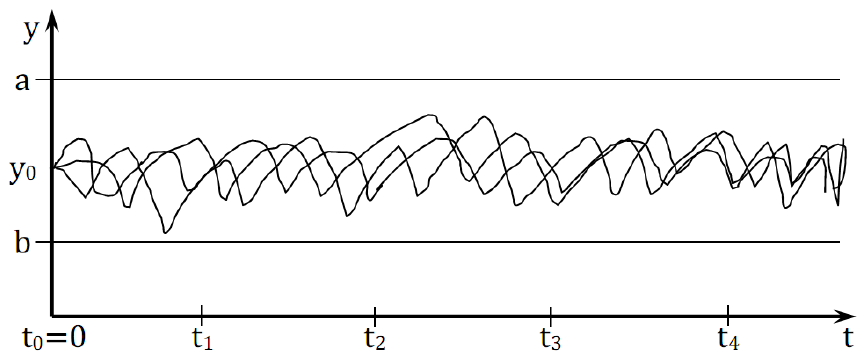
Figure 2. Diagram reflecting random particle trajectories (random walks) moving from the point ( x 1 , b ) to the point ( x 1 , a )